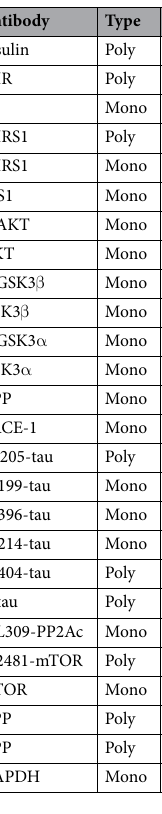
Table 1. Antibodies used in the